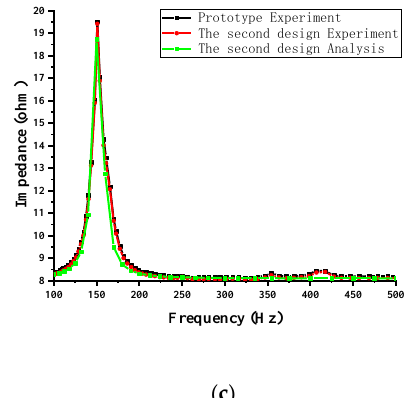
Figure 11. Results of the second design: ( a ) magnetic flux leakage; ( b ) displacement; ( c ) impedance.